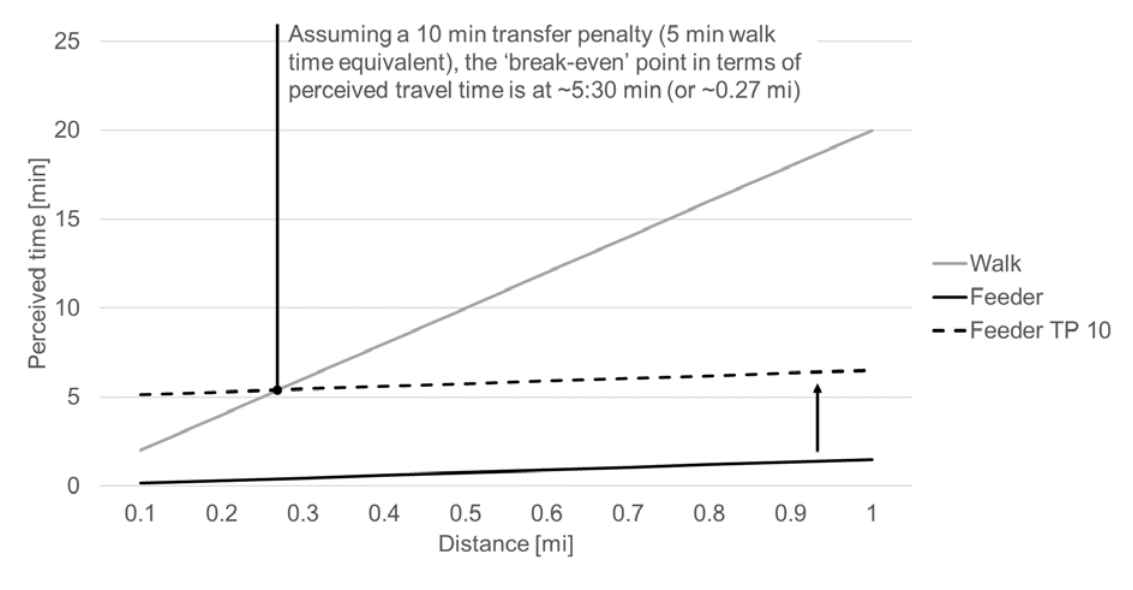
Travel time comparison for a first mile walk vs feeder service. Transfers are hypothesized to decrease their utility on short